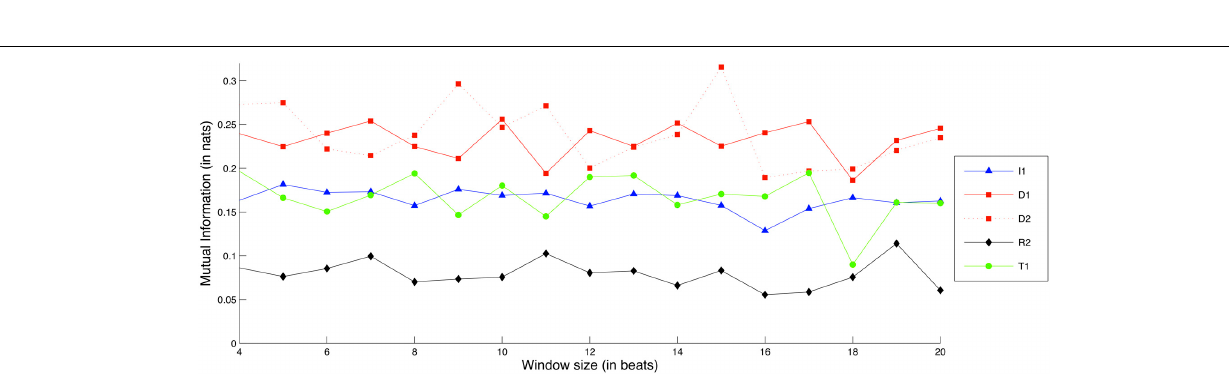
FIGURE 10 | Interdependence gain for the Dynamics dimension, for different exercises and window sizes. (Legend: I1, Intonation exercise, D1, Dynamics exercise nr.1, D2, Dynamics exercise nr.2; R1, Rhythm exercise nr.1; R2, Rhythm exercise nr.2; T1, Timbre